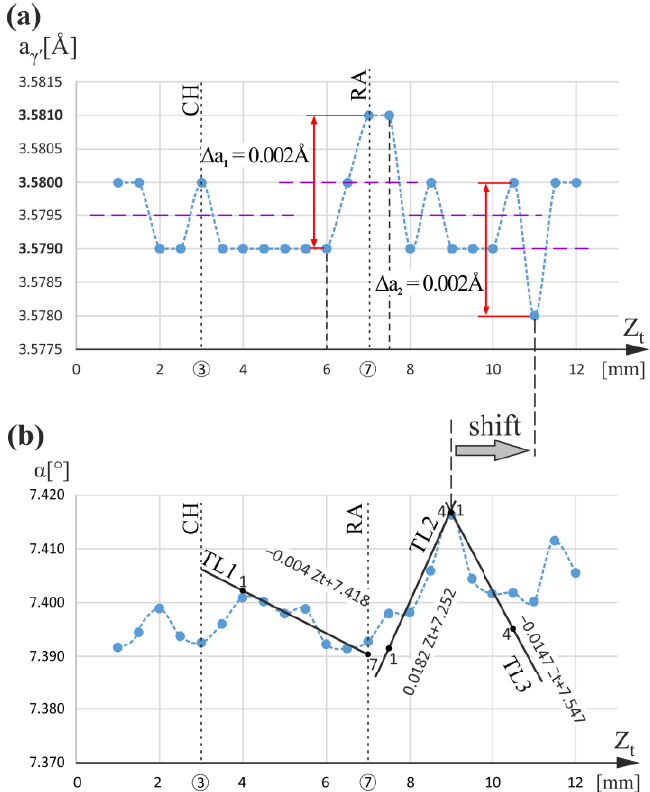
Figure 5. Graphs of the a γ′ (Z t ) ( a ) and α(Z t ) ( b ) relationships obtained for measurement line t. Z t is parallel to Z.